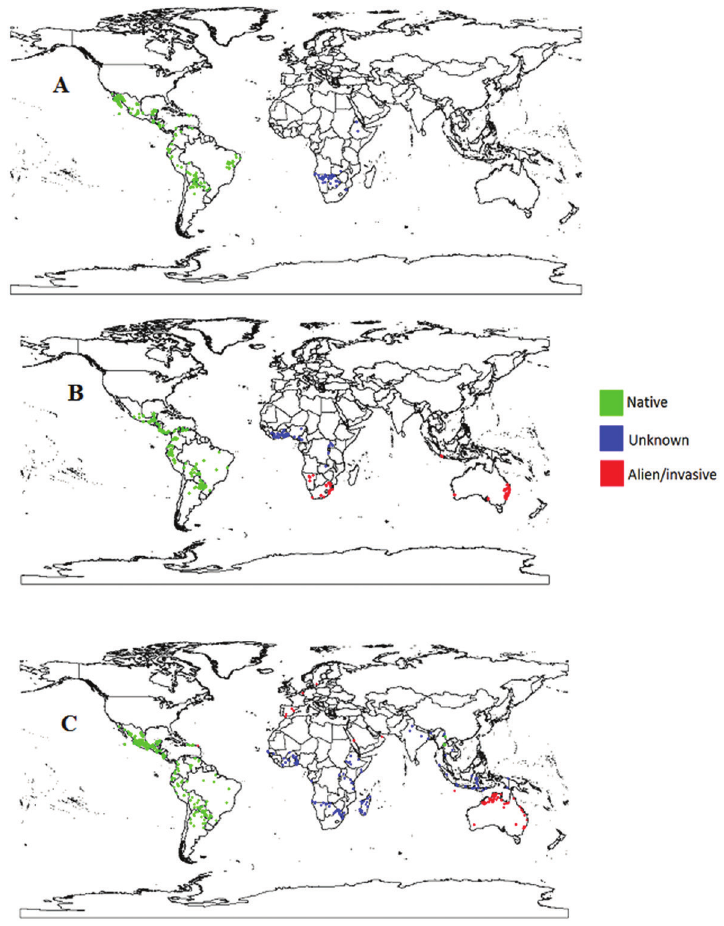
Figure 1. Distribution of Cardiospermum species. Global distribution of A C. corindum B C. grandiflo- rum and C C. halicacabum in native, unknown and alien or invasive